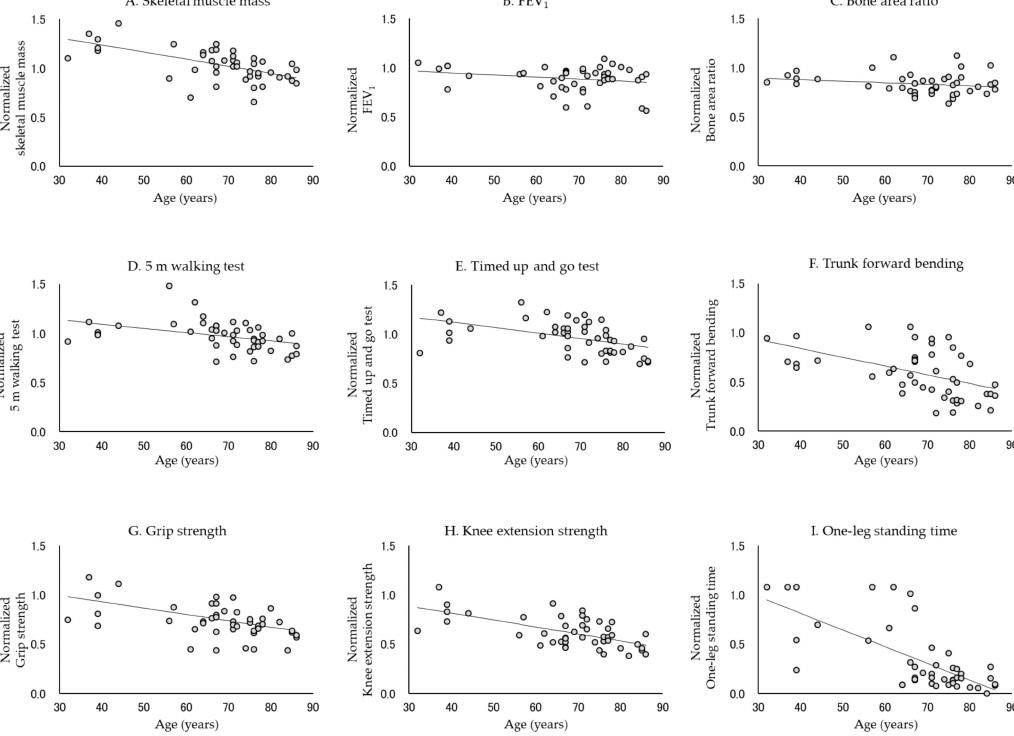
Figure 2. Normalized distribution and linear model of each physical function in men. Each physical function declines with age, except for FEV 1 and bone area ratio. In particular, the rate of decrease in one-leg standing time, trunk forward bending, skeletal muscle mass, and knee extension strength was